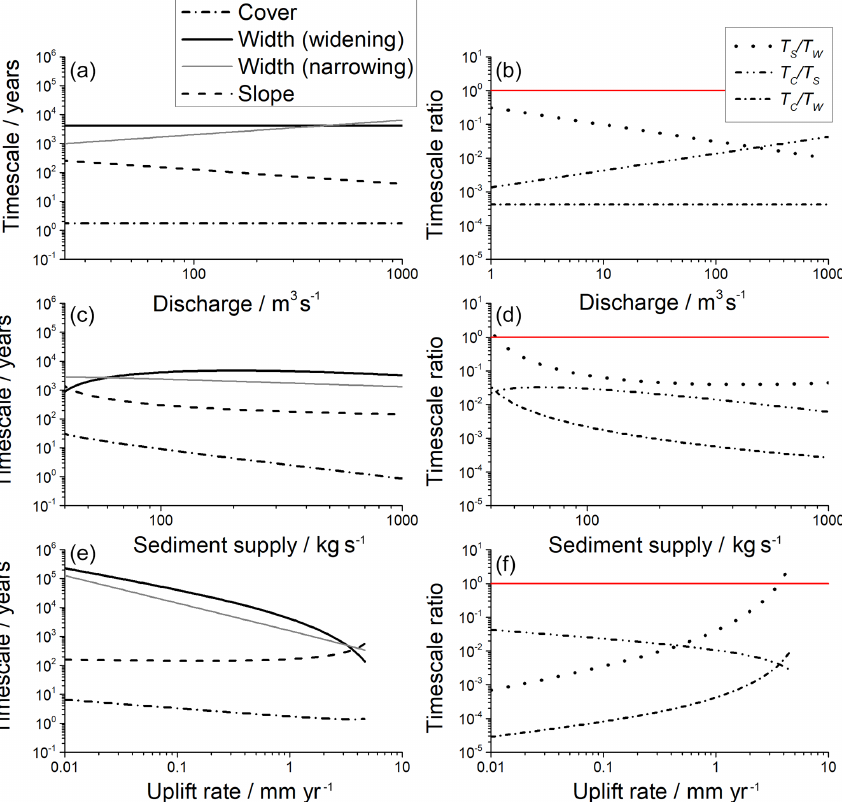
Figure 5. Timescales (a, c, e) and timescale ratios (b, d, f) for channel adjustment, using appropriate steady-state values corresponding to imposed discharge, sediment supply, and uplift rate for slope, width, and cover against forcing variables discharge (a, b) , sediment supply (c, d) , and uplift rate (e, f) . For the calculations, all other parameters have been kept constant (Table 1). For the timescale ratios (b, d, f) , only the timescale for widening channels was used, due to its similarity with the timescale for narrowing channels (a, c, e) . The solid red line in (b, d, f) indicates a ratio of